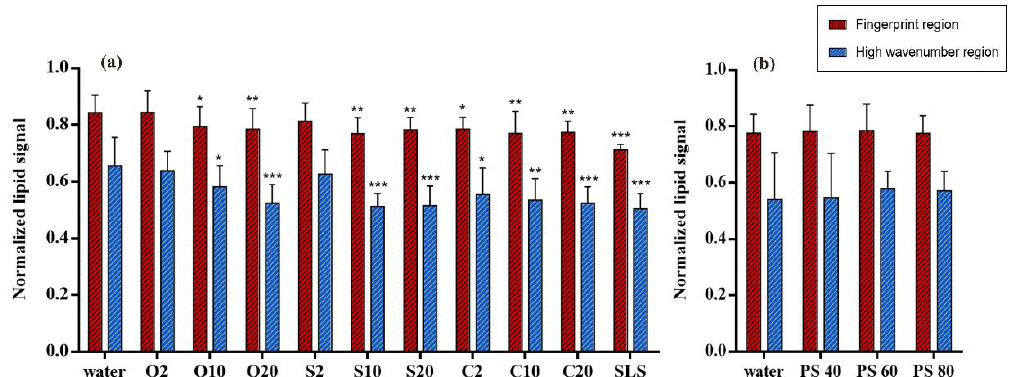
Figure 3. Normalized lipid signals in fingerprint and HWN region for lipid composition analysis of ( a ) PEG alkyl ethers treated SC and ( b ) PEG sorbitan esters treated SC. Mean ± SD, n = 18. * p < 0.05; ** p < 0.01; *** p < 0.001.